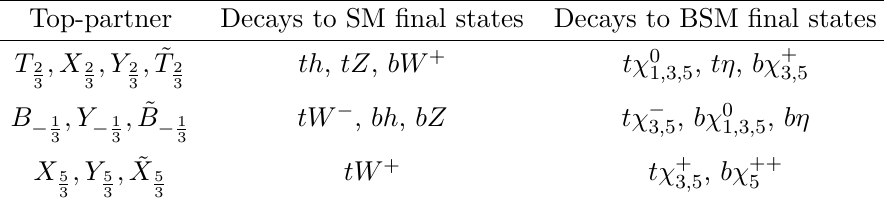
√ s = 13 TeV and 14 TeV,